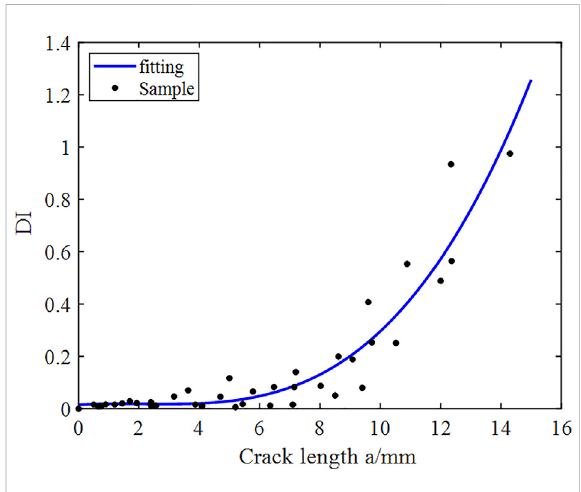
FIGURE 7 The DI values corresponding to different crack lengths.